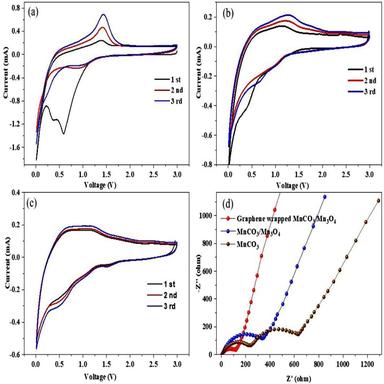
Cyclic voltammetry of (a) bare MnCO3, (b) MnCO3/Mn3O4 and (c) graphene-wrapped MnCO3/Mn3O4 nanocomposite, (d) Nyquist plots of different anode materials.